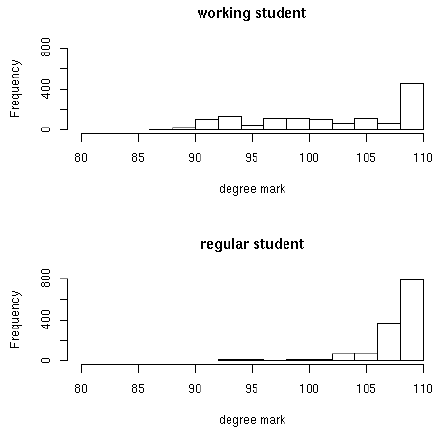
Figure 7 – Histograms of the conditional distribution of the final mark for working students (sex= male, place of residence=outside Marche, course attendance=no, diploma mark=lowest) and for regular students (sex=female, place of residence=Macerata, course attendance=regular, diploma